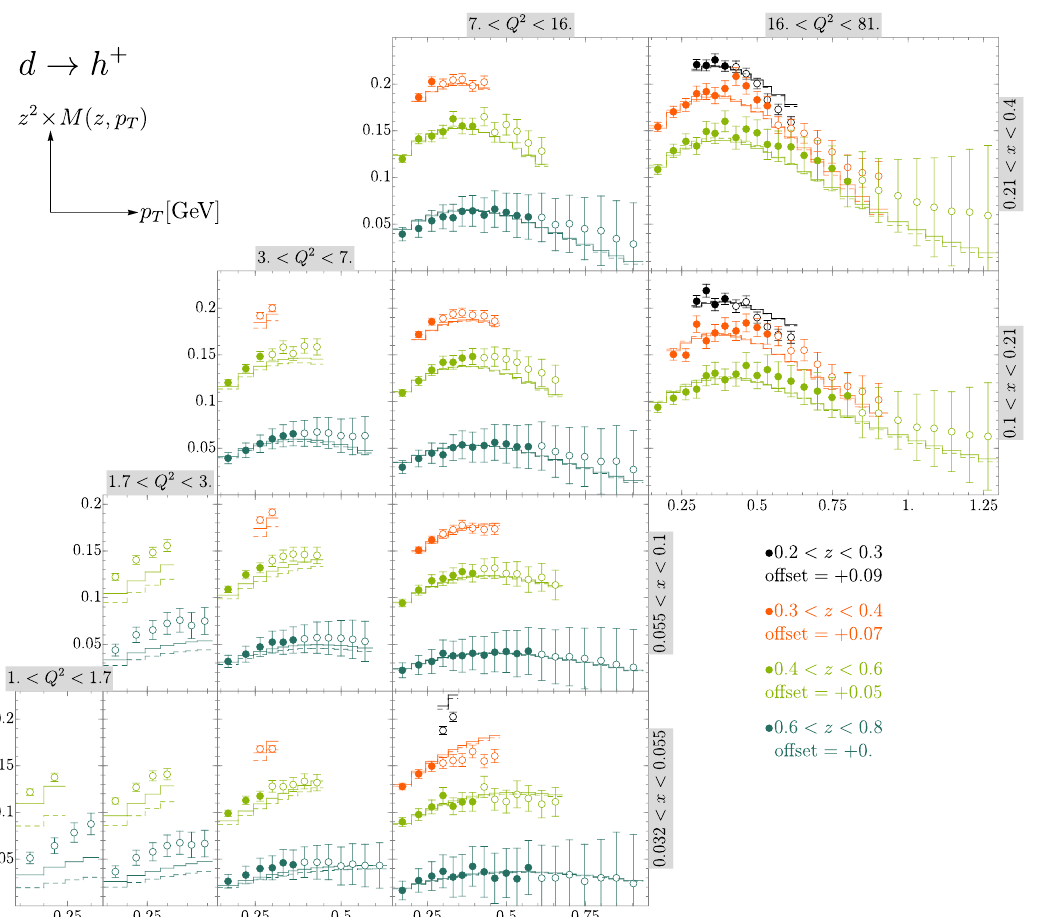
Figure 19 . Unpolarized SIDIS multiplicities (4.4) (multiplied by z 2 ) for production of positively charged hadrons o(cid:11) deuteron measured by COMPASS in di(cid:11)erent bins of x , z , Q and p T . Solid (dashed) lines show the theory prediction at NNLO (N 3 LO). Filled (empty) point were (not) in- cluded in the (cid:12)t of NP parameters. For clarity each p T bin is shifted by an o(cid:11)set indicated in the legend. The continuation of the picture is in (cid:12)gure 21.